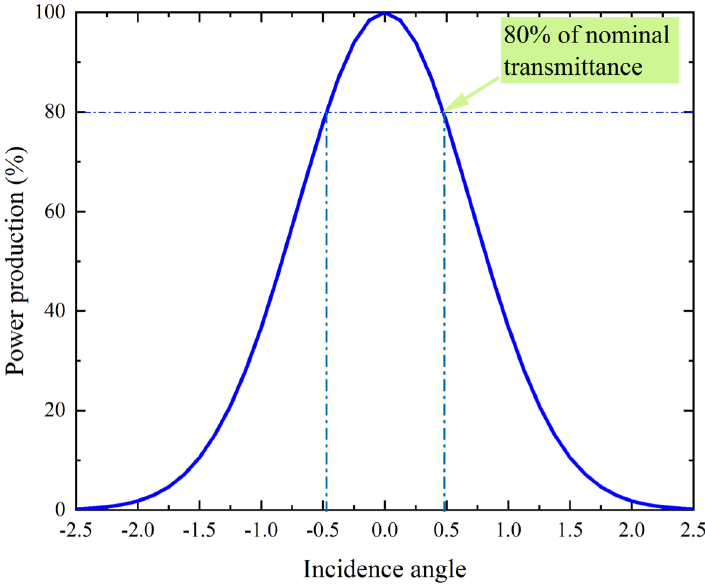
Figure 3. Hypothetical power production of a